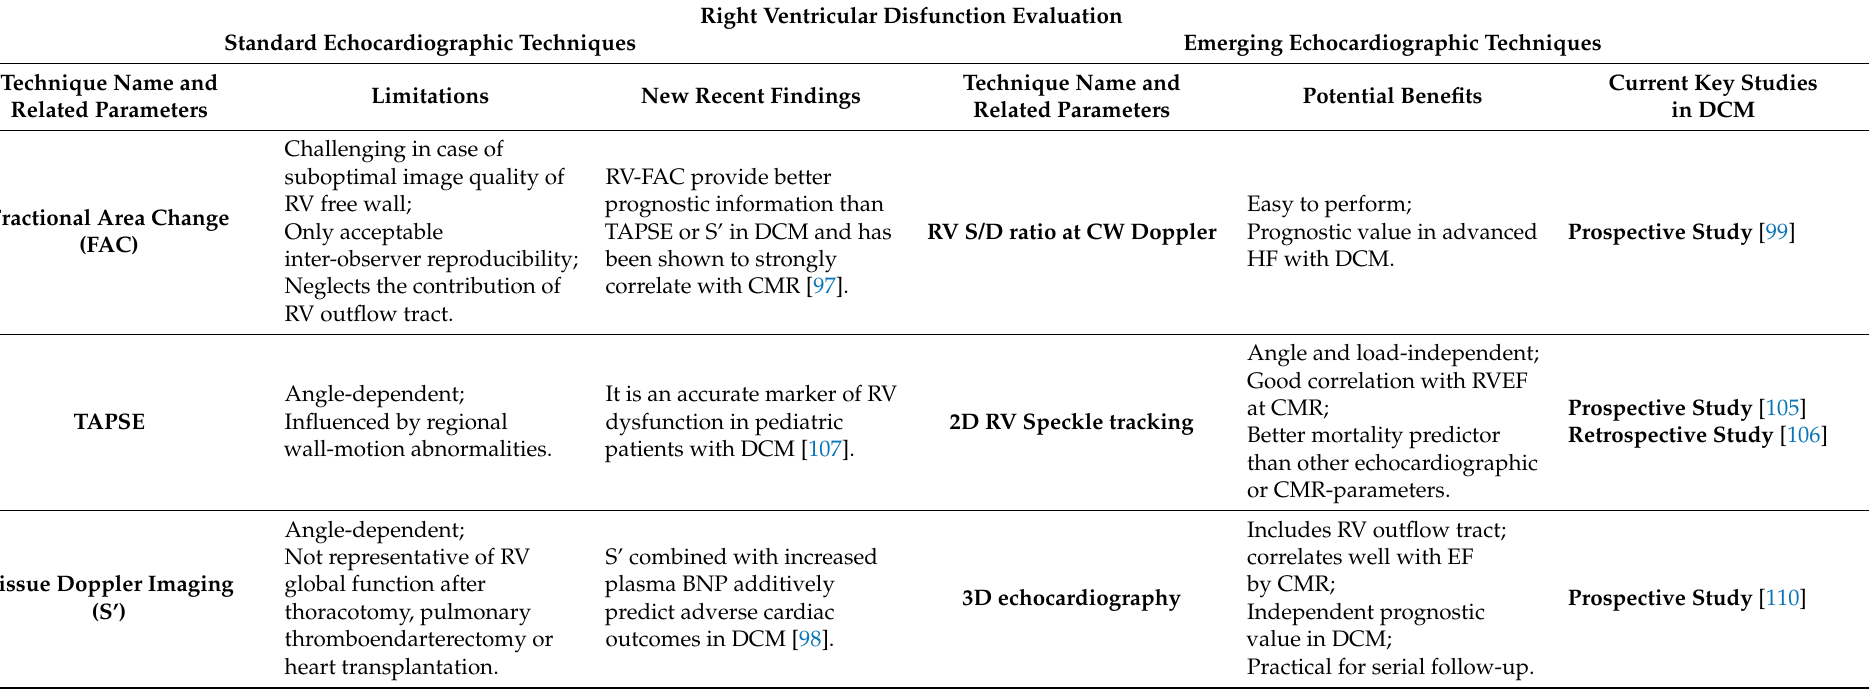
Table 3. Comparison between Standard and Emerging echocardiographic techniques to evaluate right ventricular disfunction in dilated